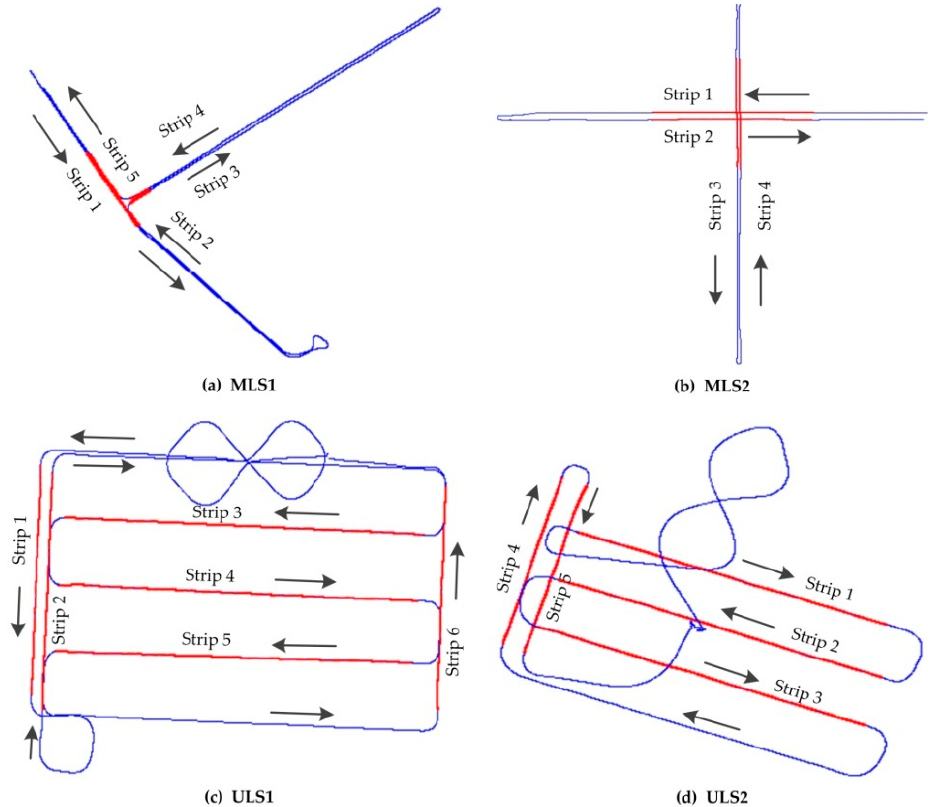
Figure 2. The trajectories of the experimental data where the highlighted red parts are selected for calibrating and the arrows indicate the travel direction of MLS systems and ULS systems in data acquisition.